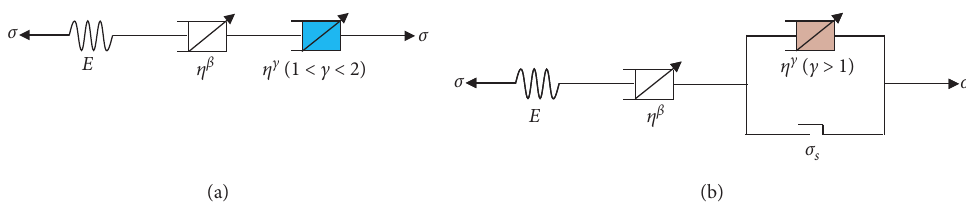
Figure 13: Schematic diagram of the creep model based on fractional derivatives theory by adjusting the value range of derivative order β (a) proposed by Wu et al. [41] (1 < c < 2) and (b) proposed by Chen et al. [133] ( c > 1).